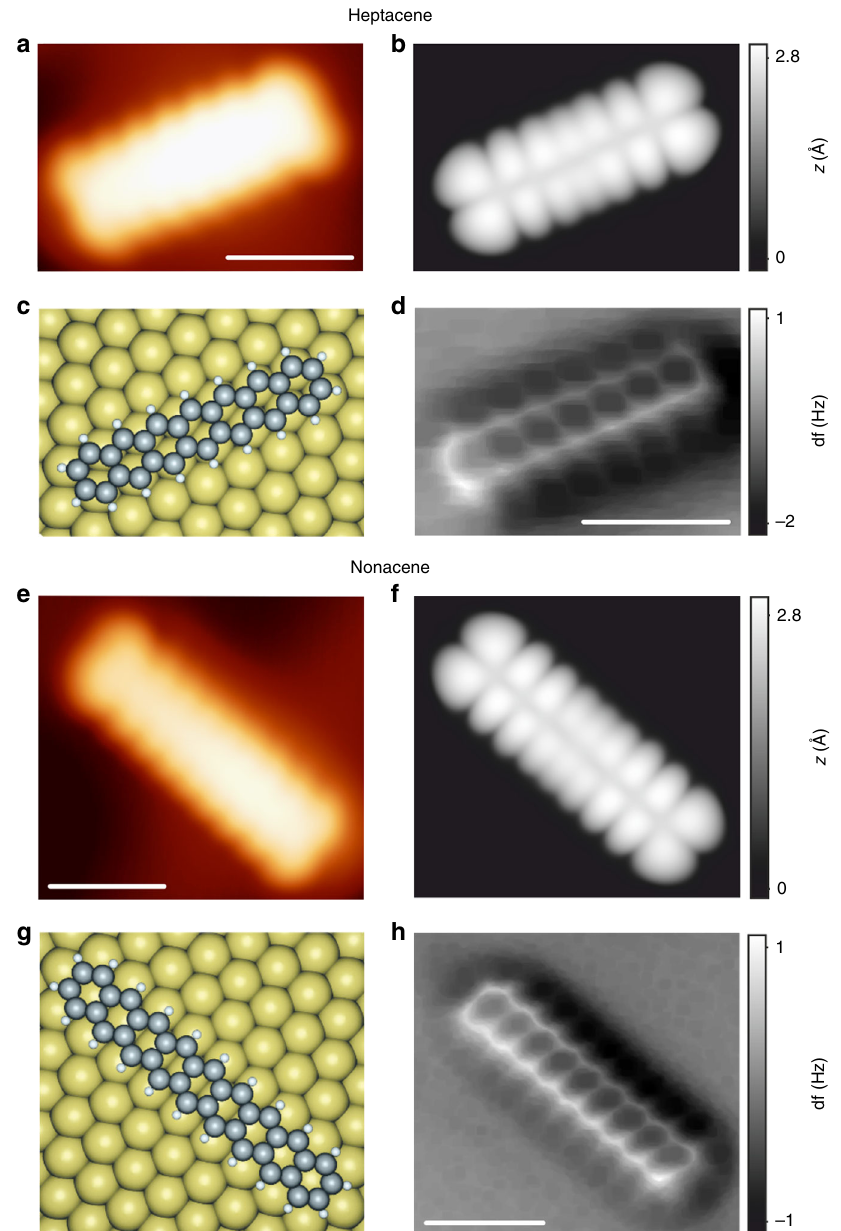
Fig. 4 Heptacene and nonacene on Au(111) surface. a , e High-resolution STM images of heptacene and nonacene species, respectively. Nonacene was obtained by the procedure described in Fig. 2f. V b = − 1 V, I = 4 pA. b , f DFT simulated STM images at − 1 V. c , g Top view of the DFT equilibrium geometries of heptacene and nonacene adsorbed on Au(111). d , h Constant-height frequency-shift nc-AFM images acquired with a CO-functionalized tip (z-offset 30 pm below STM set point at − 5 mV, 10 pA). Scale bars 1